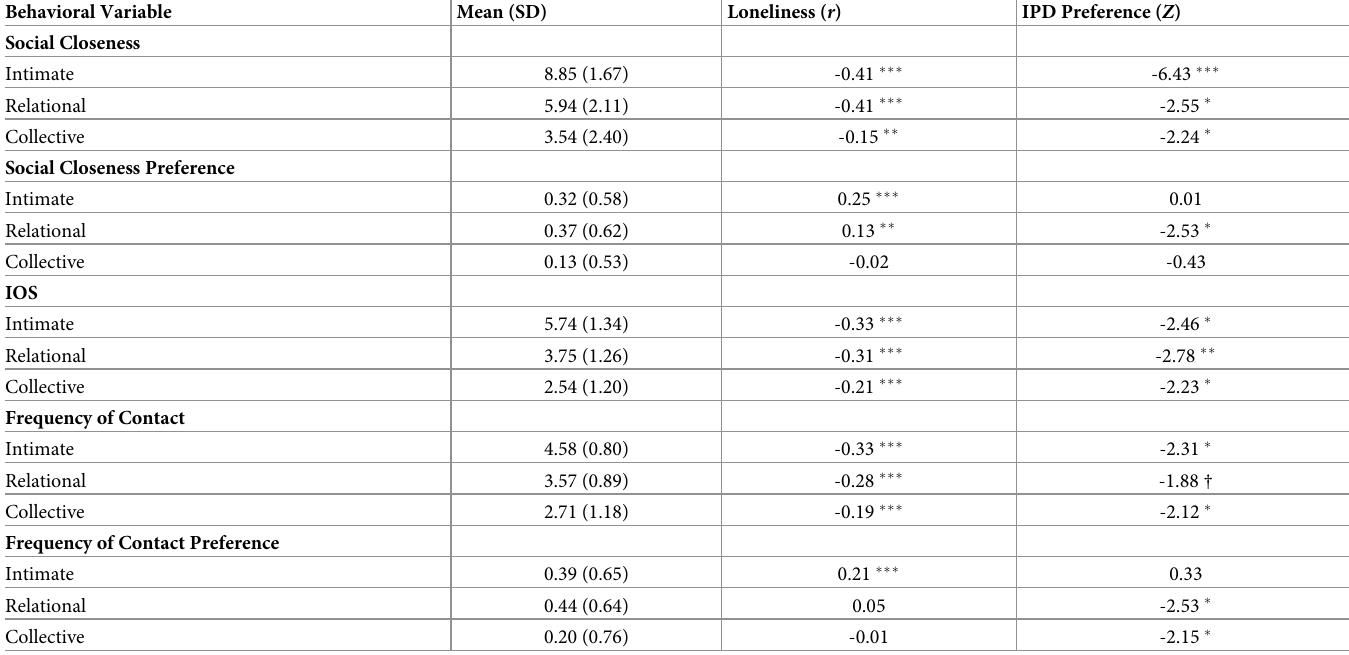
Table 3. Putative